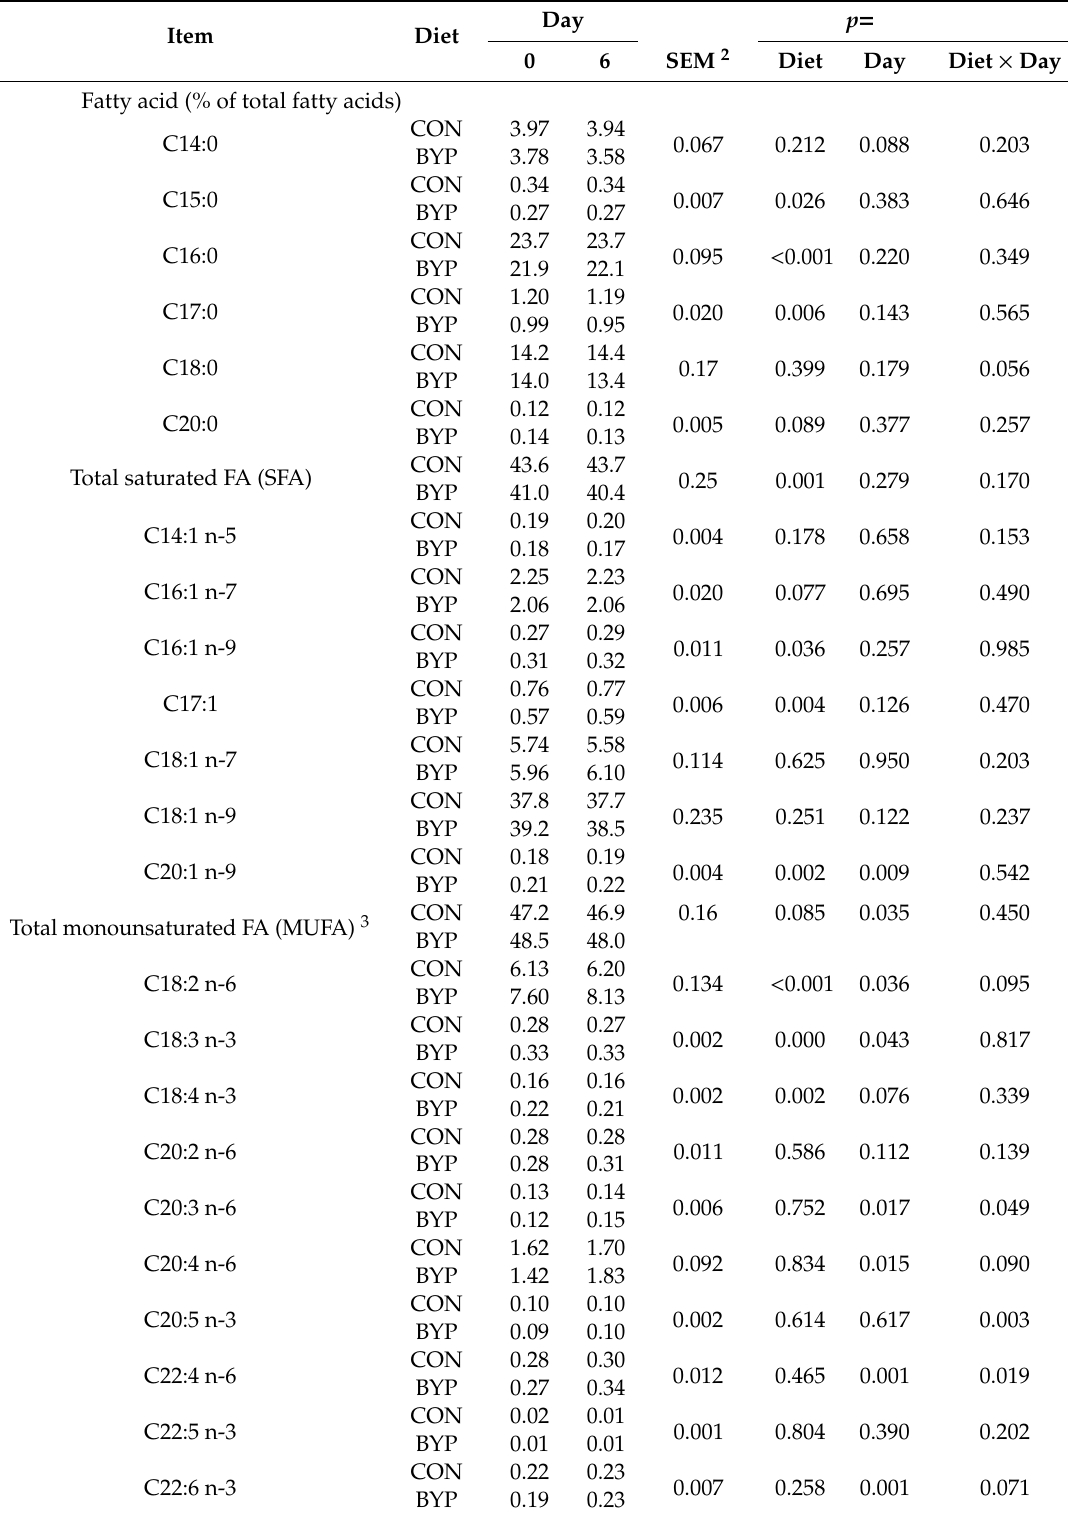
Table5. Fattyacid(FA)profile, peroxidationindex, andindexesrelatedtohumanhealthofintramuscular fat of the longissimus dorsi muscle of light lambs fed either a high-cereal concentrate (CON) or a concentrate including by-products (BYP) 1